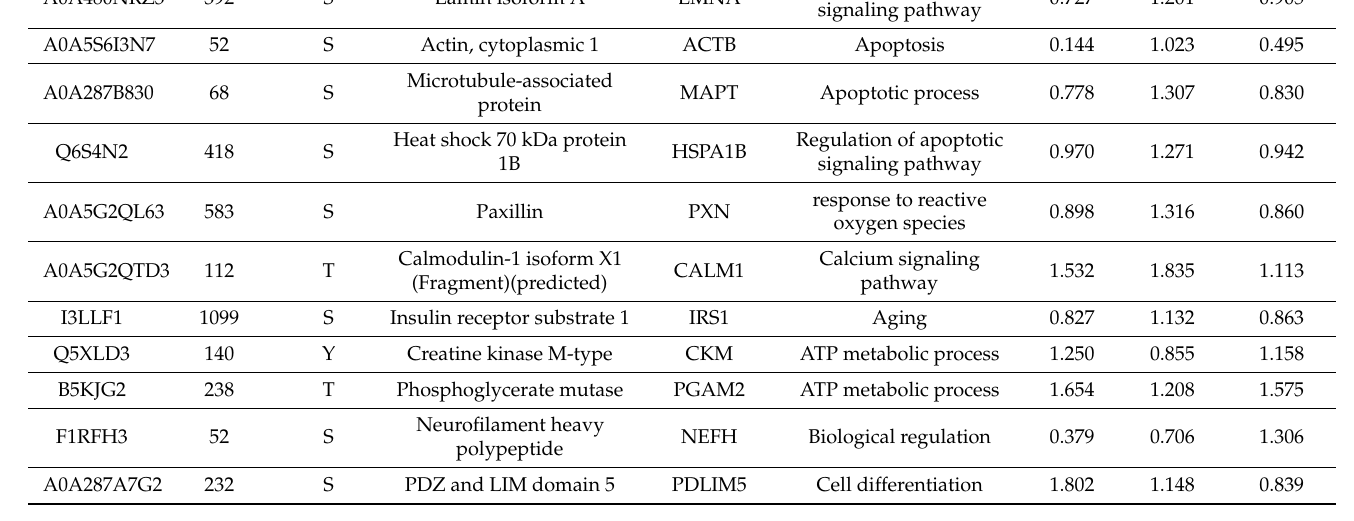
Figure 4. ( a ) Mfuzz analysis of differentially expressed protein profiles in postmortem pork muscle. The shade of red and blue represents high expression and low expression, respectively. ( b ) Protein – protein interaction (PPI) networks of differentially expressed proteins in postmortem pork muscle. The interaction network only presented proteins with connections.